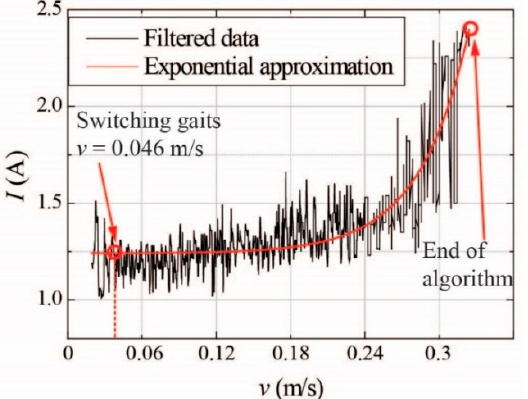
Figure 6. Current-time diagram, achieved by varying robot speed and gaits. Black curve—filtered experimental data; red line—exponential approximation.